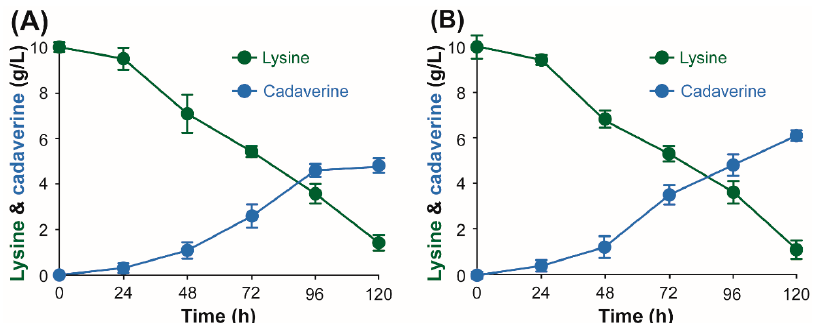
Figure 3. Time profiles of L -lysine consumption and cadaverine synthesis by recombinant E. coli XBEcLDC ( A ) and XBHaLDC ( B ) harboring E. coli ldcC gene and H. alvei ldcC , respectively. Recombinant strains were cultivated for 24 h in anLB medium and transferred into a 250 mL flask with a PLP-free MR medium with 20 g/L of glucose and 10 g/L of chemical-grade L -lysine for further cultivation at 37 °C (Symbols: filled circle, L -lysine concentration; open circle, cadaverine concentration).